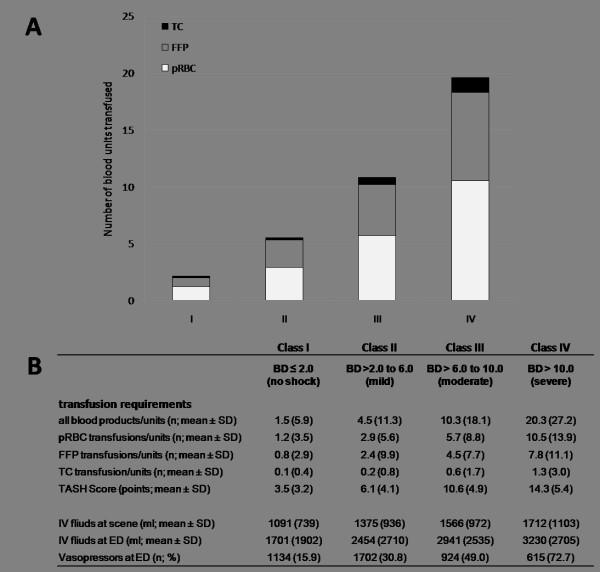
Hemostatic and fluid resuscitation in patients classified by base deficit (BD) into classes I to IV. (a) Total amounts of packed red blood cells (pRBCs), fresh frozen plasma (FFP), and thrombocyte concentrate (TC) transfused. (b) Transfusion requirements and fluid resuscitation (n = 16,305; P < 0.001). ED, emergency department; IV fluids, intravenous fluids; SD, standard deviation; TASH, Trauma-Associated Severe Hemorrhage.